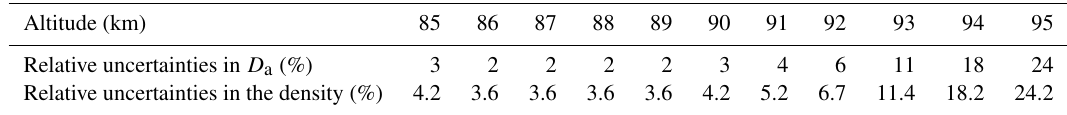
Table 2. The relative uncertainties in D a and the density from 85 to 95km. Altitude (km) 85 86 Relative uncertainties in D a (%) Relative uncertainties in the density